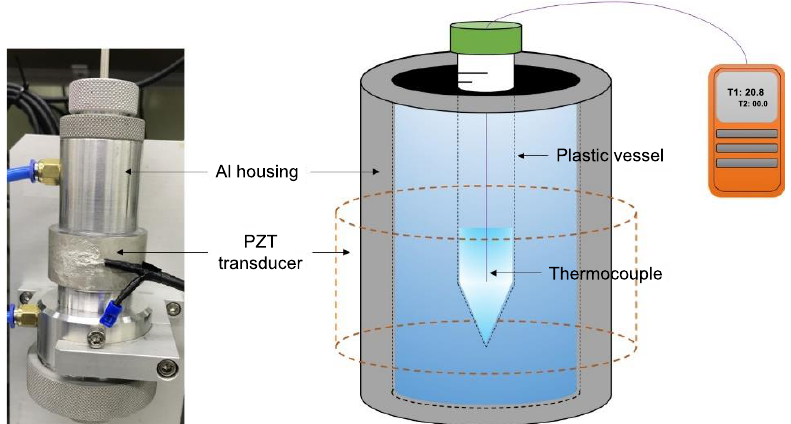
Figure 2. Photograph and schematic of the setup used to measure ultrasonic power by the calorimetry method.